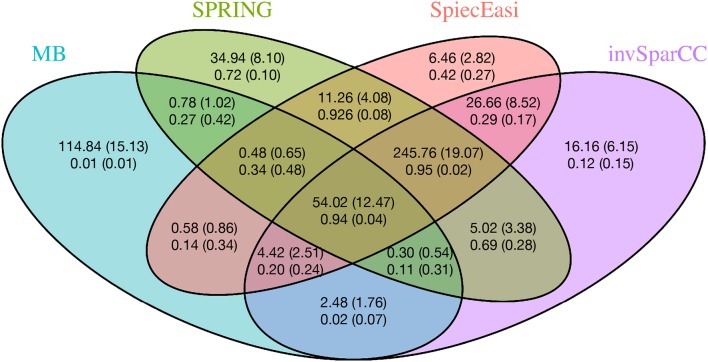
Average number of overlapping edges (top row) and the average proportion of true edges in each corresponding overlap (bottom row) for four methods over 50 replications with n = 500, p = 200, and cluster-type graph. Corresponding standard deviations are given in parentheses.